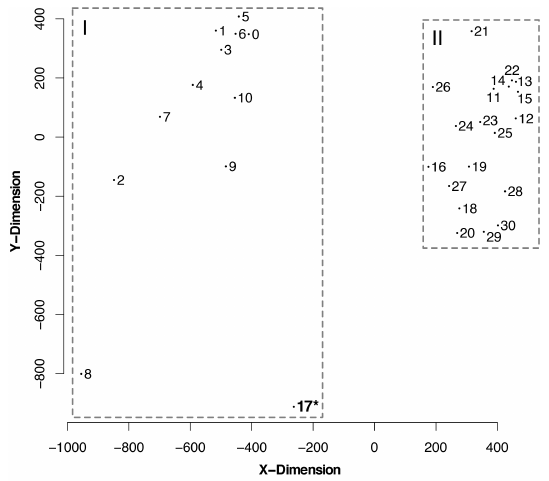
Figure 5. Sammon projection showing the multidimensional scaling of match-split distances among trees. The graphic displays the relationship among different tree topologies, clustering them into distinctive groups. Outgroup sequences ( Hepacivirus , Pegivirus , and Pestivirus ) were removed to guarantee the compared tree topologies would have the same terminals. Tree numbers correspond to those in Table 1. ( I ) Outgroup sequences and partitioned matrices. * This tree was produced without outgroup sequences. ( II ) No outgroup sequences; some matrices were partitioned. See Figure S1 (Supplementary Materials) for a dendrogram depicting the hierarchical clusters of trees based on match-split